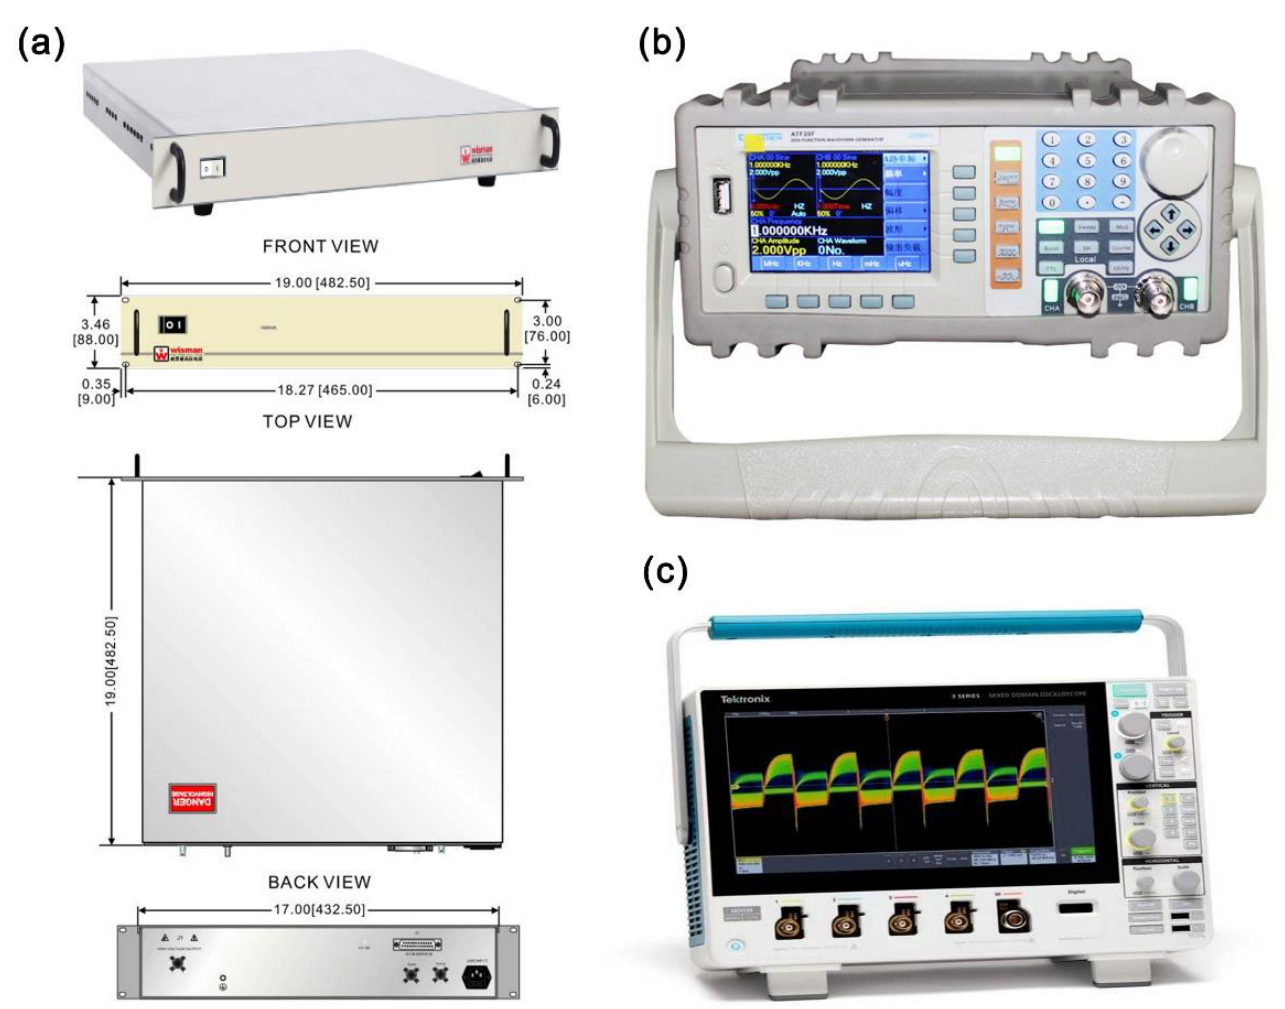
Figure 1. Main experimental equipment for the actuation mechanism experiment of flexible actuator based on PAM conductive hydrogel electrodes: ( a ) high-voltage power amplifier; ( b ) function signal generator; ( c ) digital oscilloscope.